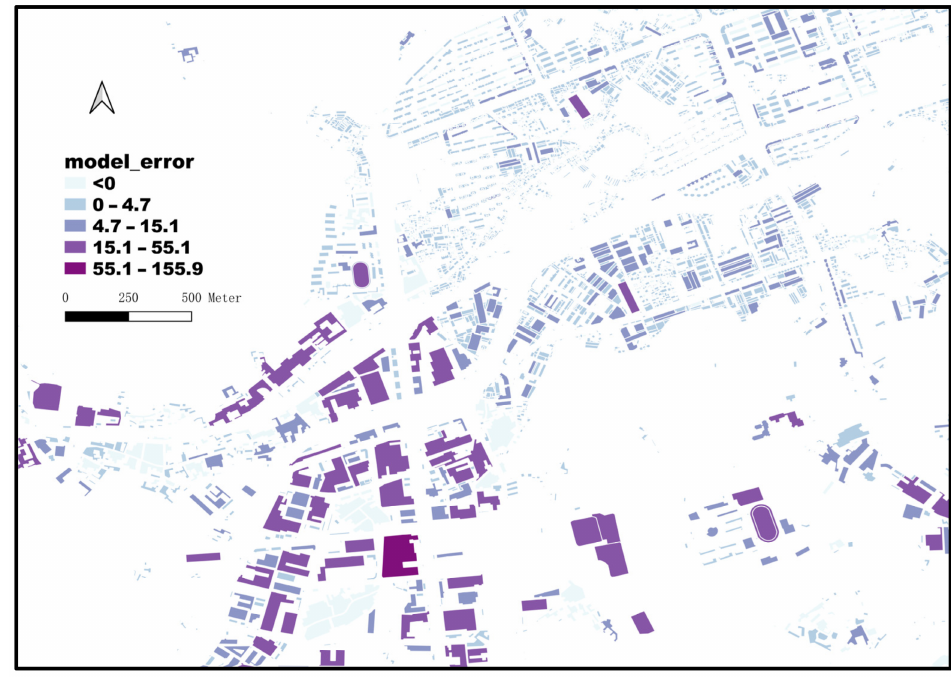
Figure 10. Error in the ML model.